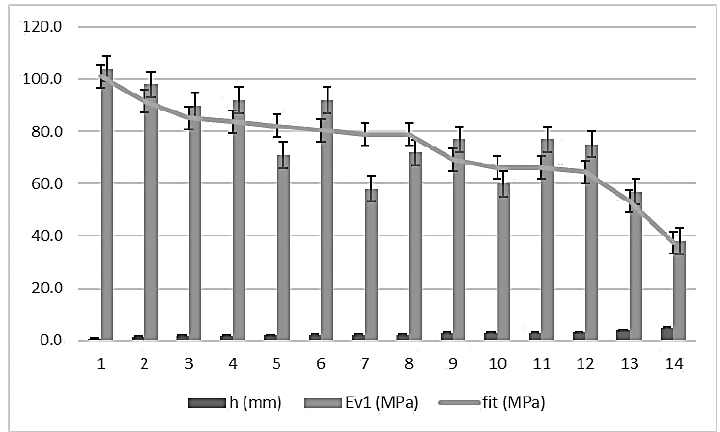
Figure 4. Error bars for topographic settlement and second modulus of PLT ( ɸ 600mm).